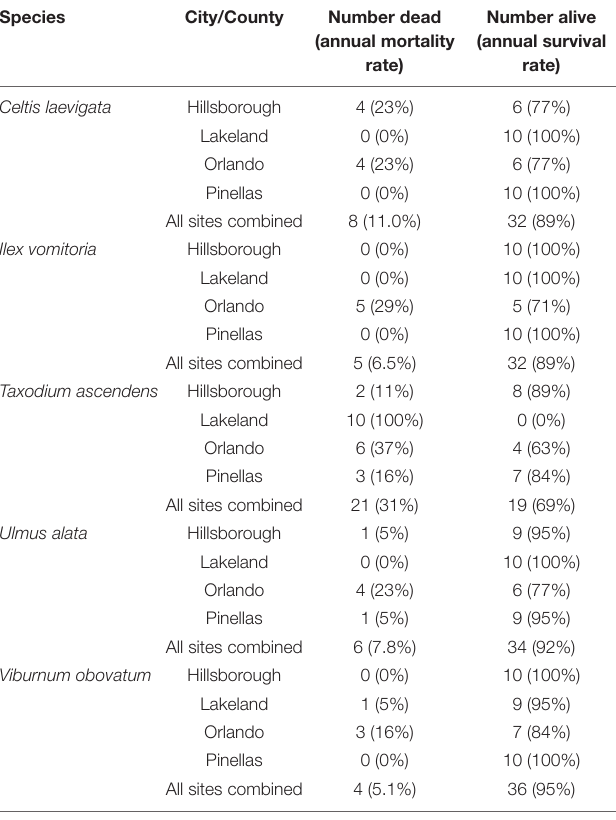
TABLE 2 | Overview of annual mortality and survival rates for the different establishment trial species.